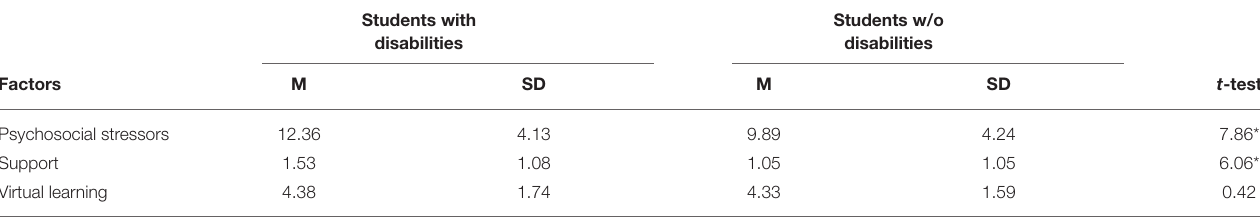
TABLE 3 | Disability status comparisons using Independent Samples T -tests.